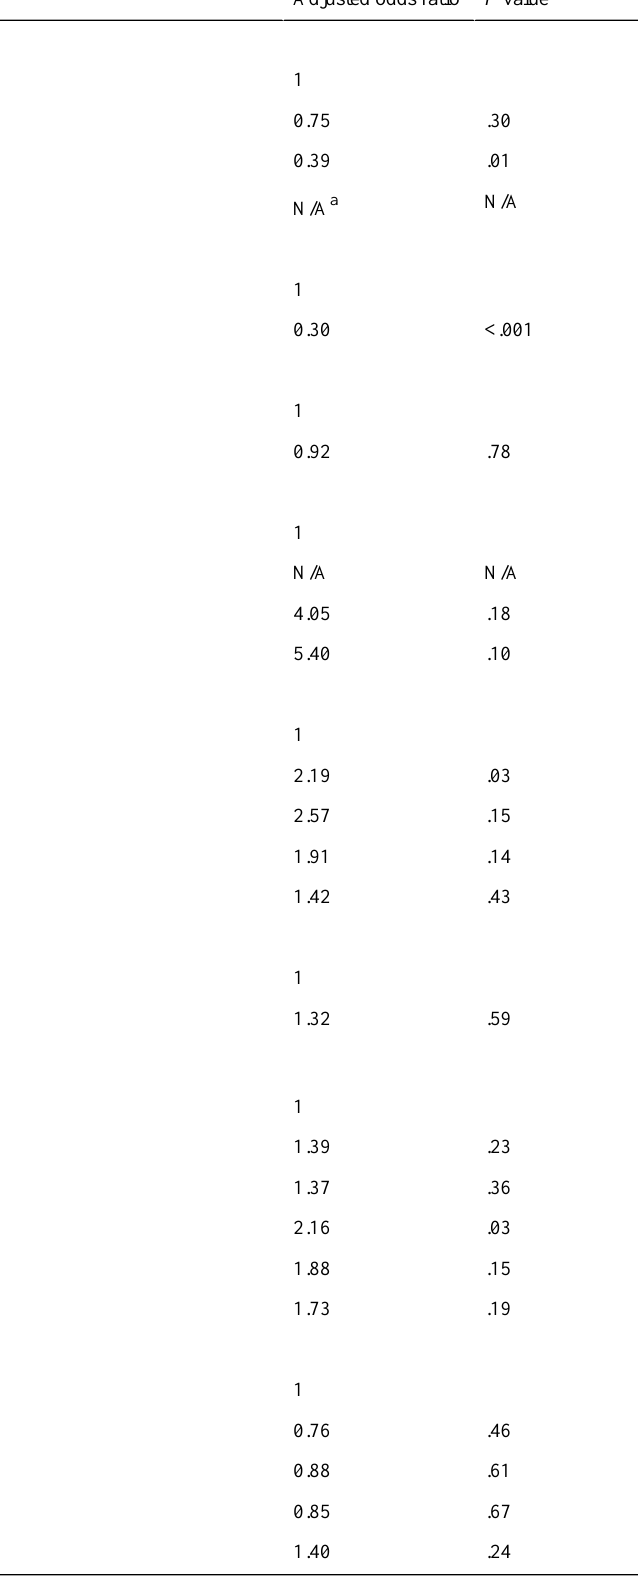
Table 5. Multivariable analysis of the factors associated with daily steps synced with Health4U.